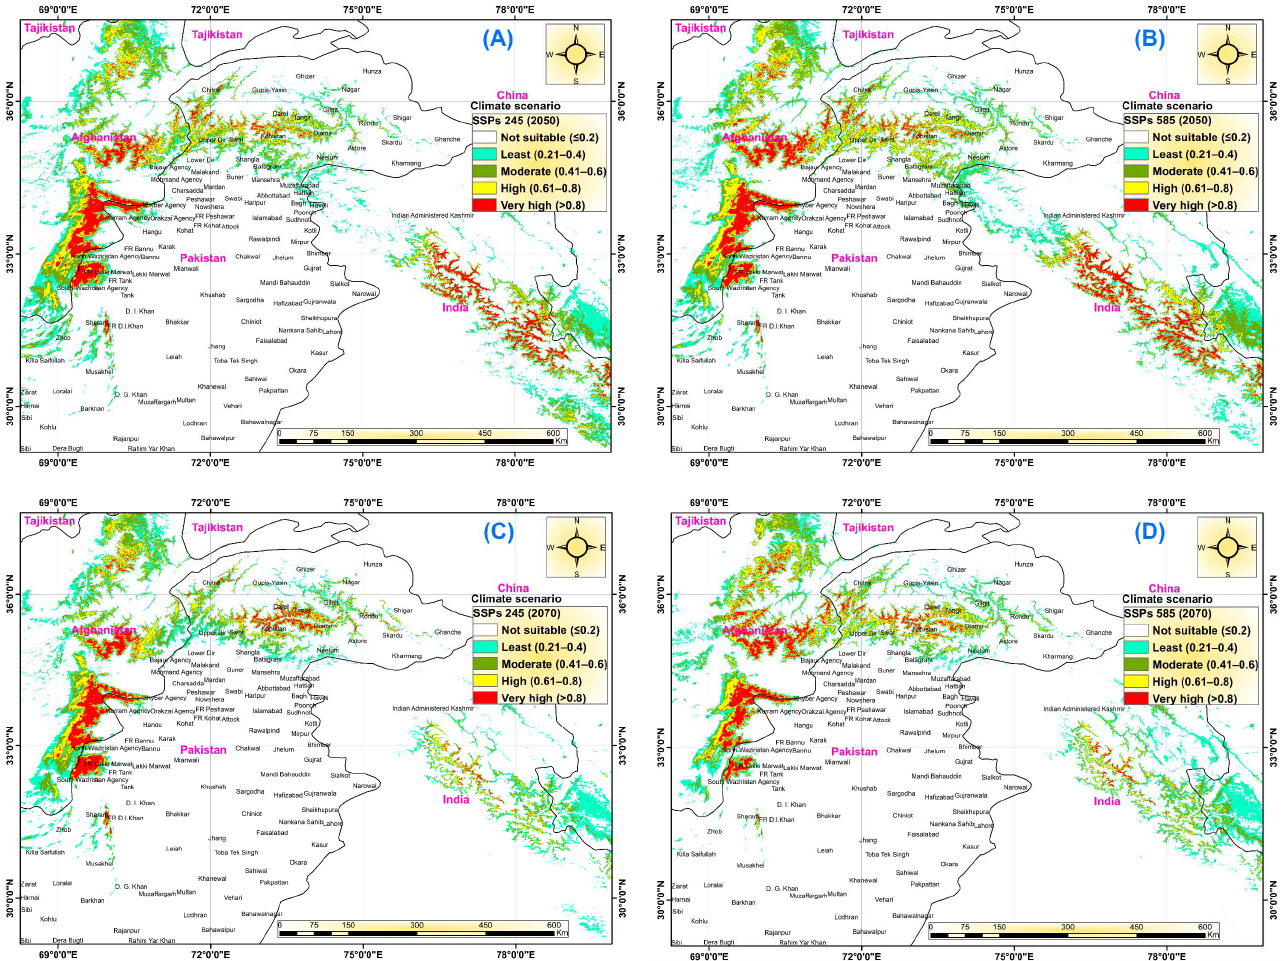
Figure 7. Predicted habitat suitability variations of Pinus gerardiana under projected future climate change scenarios (Colour coding is same as in Figure 6; ( A ) = SSPs 245; ( B ) = SSPs 585 of 2050s and ( C ) = SSPs 245; ( D ) = SSPs 585 of